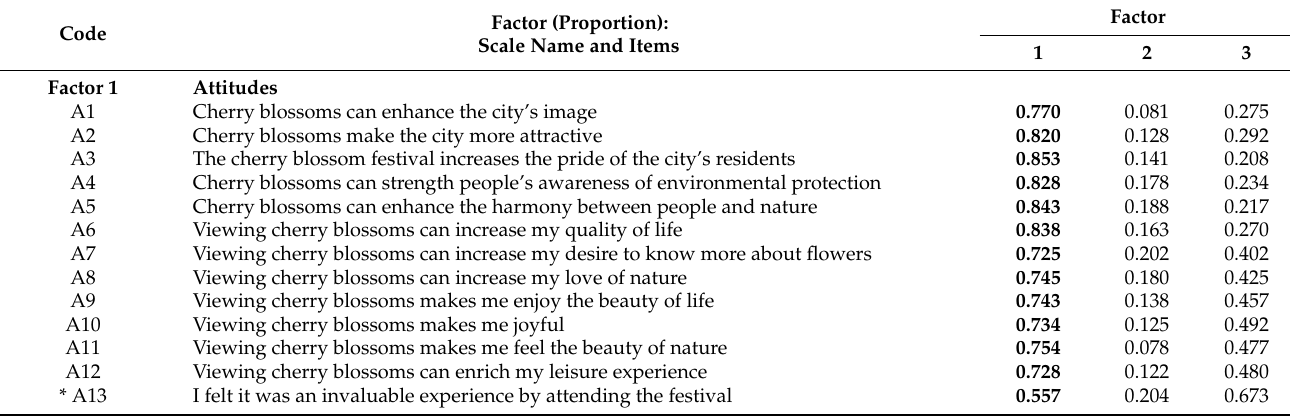
Table 3. Exploratory factor analysis for attitudes, past experience, and